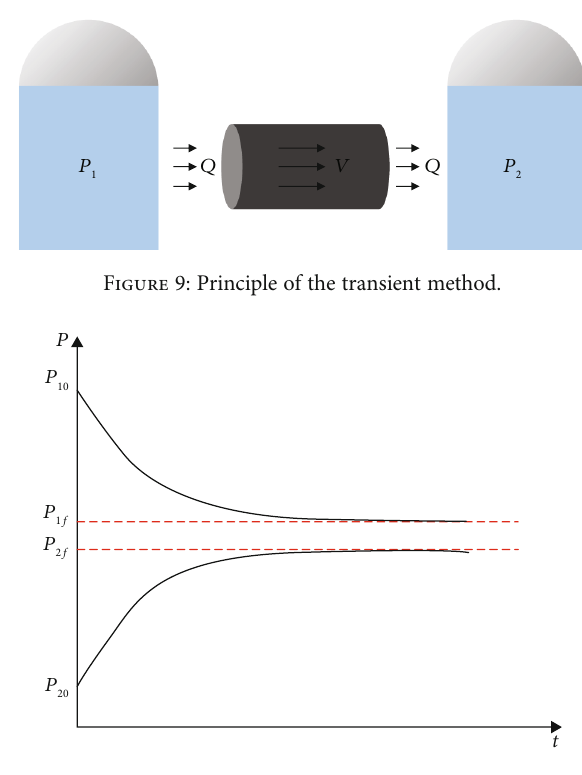
Figure 10: Pressure change curves for the water